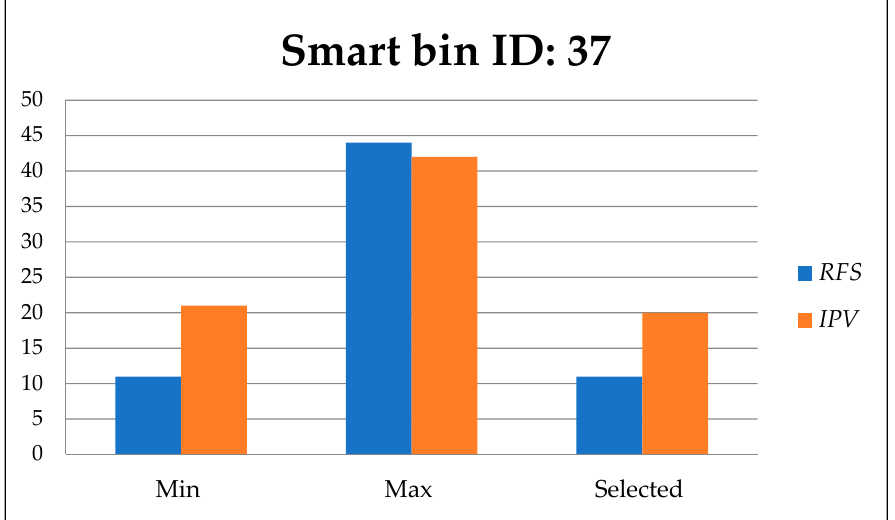
Figure 15. Residual free space R fs , and importance priority value IPv to smart bin id: 37.